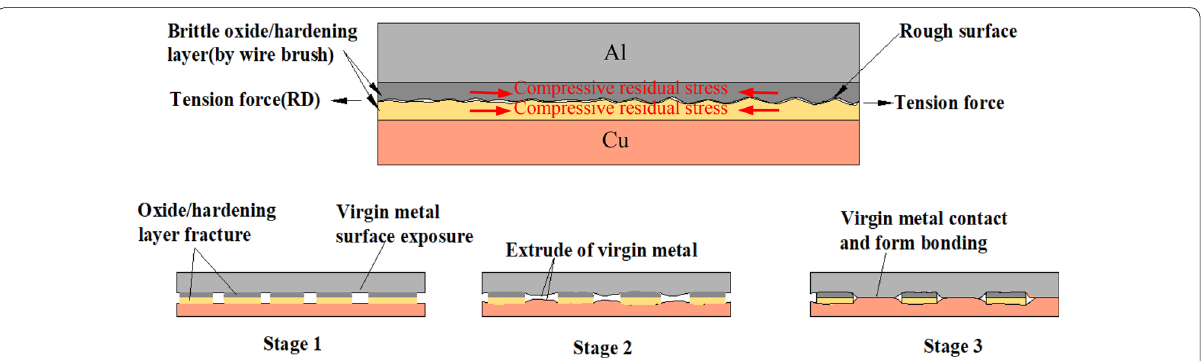
Fig. 11 Schematic diagram of bonding mechanism for the CRB Cu/Al clad